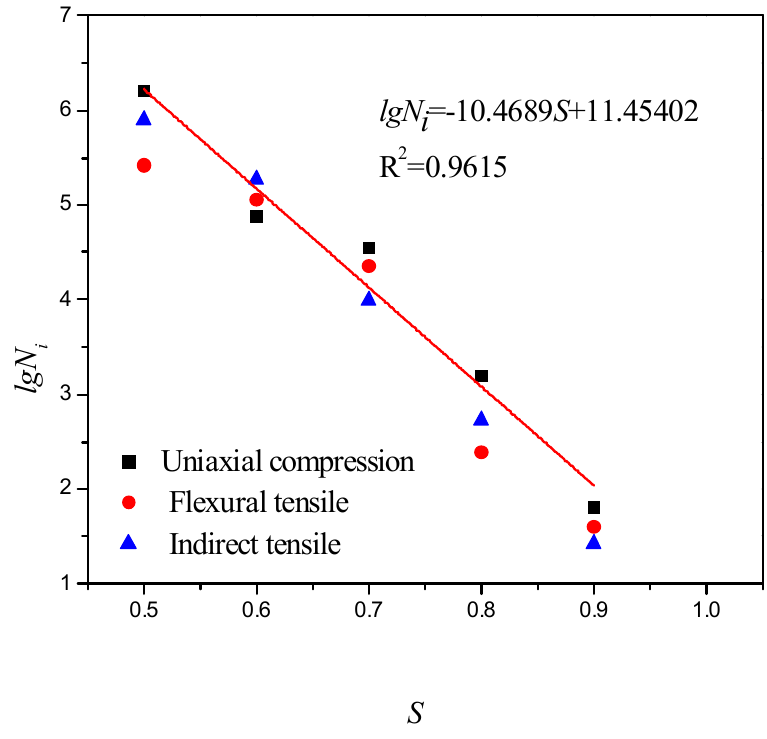
Figure 10. Standardization equations for the fatigue properties with a cement content of 4% at a curing time of 28 days and a guaranteed rate of 95% under different stress states.